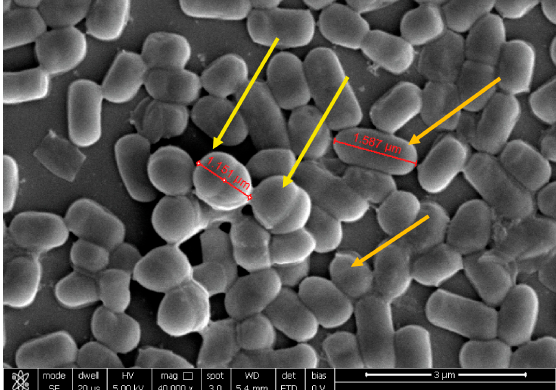
Figure 2. Representative image of L. plantarum PBS067 and G. vaginalis observed at SEM. The yellow arrows indicate G. vaginalis , the orange arrows L. plantarum PBS067. Magnification 40,000×.